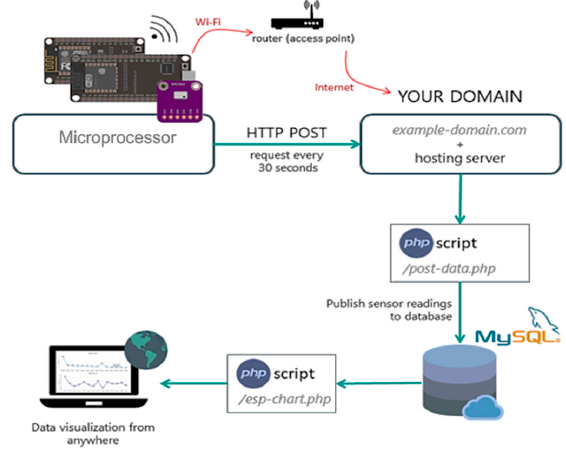
Figure 6. Data flow and communication between the smart meter and remote server.